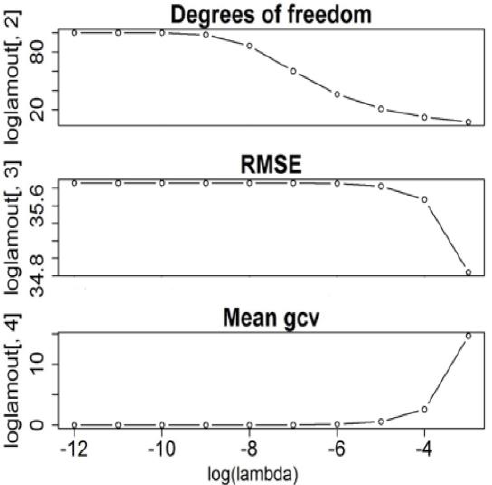
Figure 4. Graphs of degrees of freedom ( df ), root mean squared error (RMSE), and generalized cross-validation (GCV) vary with various values of λ. Table 1. Various values of with their respective df , RMSE, and GCV.